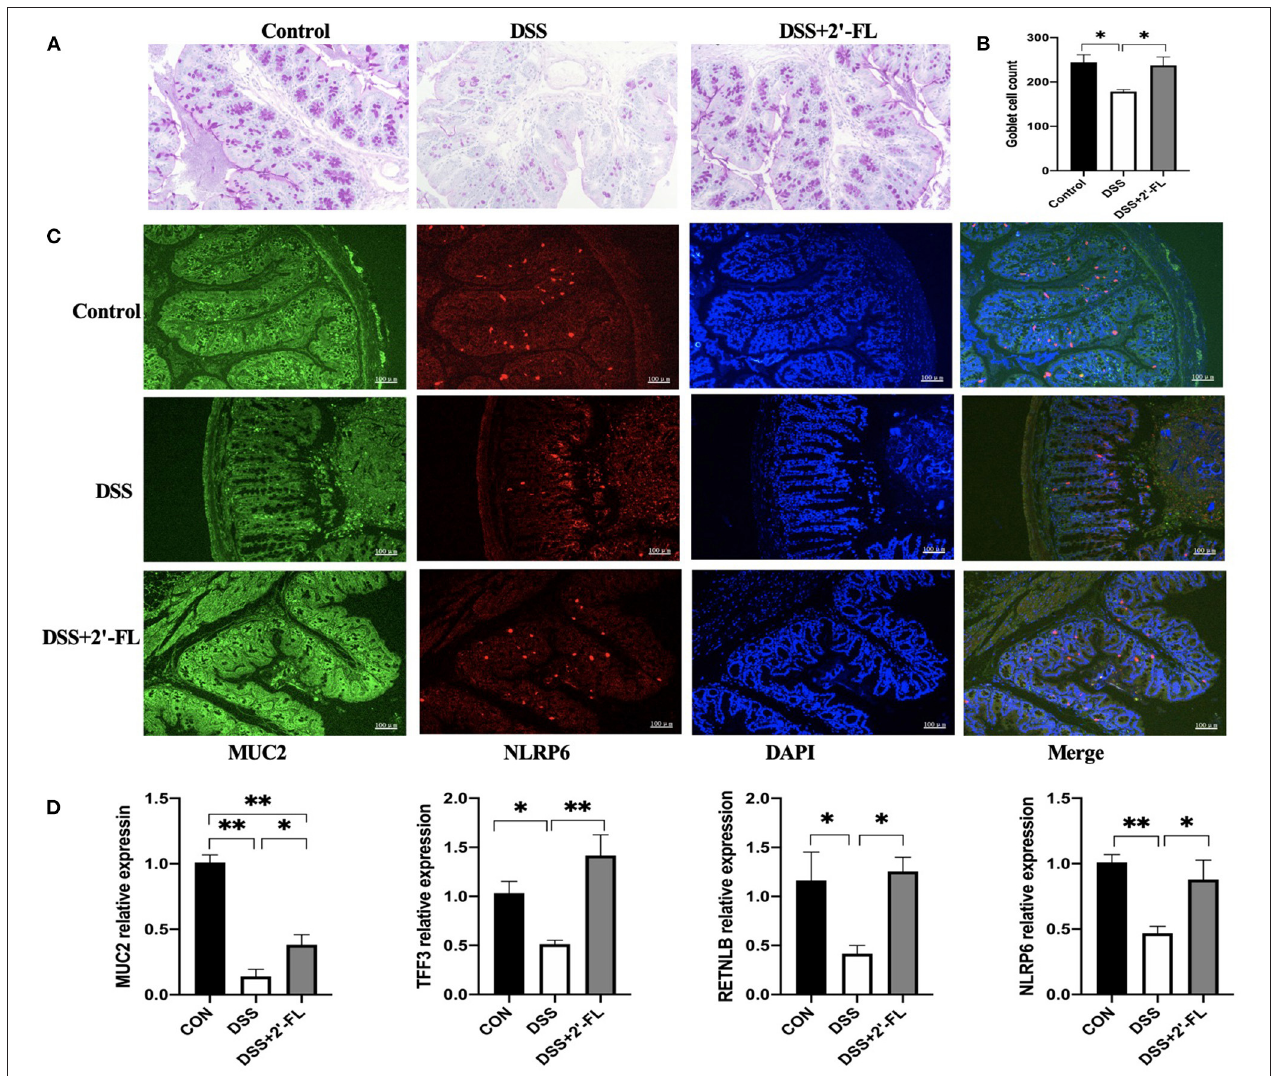
FIGURE 7 | 2 ′ -FL increases the number of goblet cells and mucin expression. (A) Representative periodic acid-Schiff (PAS)-stained distal colon sections showing goblet cells. Scale bar, 100 µ m; (B) The number of goblet cells in distal colon; (C) Representative fluorescent images of MUC2 (green) and NLRP6 (red) in colon tissue. (D) Quantitative RT-PCR showing expression of MUC2, TFF3, RETNLB and NLRP6, relative to GAPDH. Significance was determined using one-way ANOVA and expressed as mean ± SEM. ( n = 6 for each group). * p < 0.05; ** p <